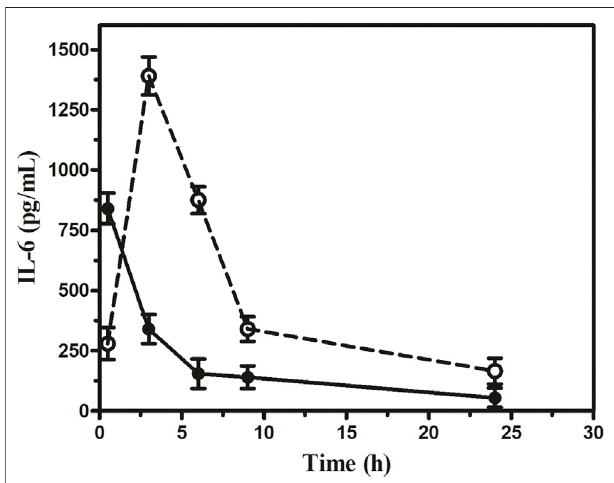
FIGURE 7 | Assessment of interleukin-6 at the different dosages of phage cocktail given 6 h after bacterial challenge. The open circle ( ○ ) denotes (1 × 10 12 PFU/mouse), and the closed circle ( mouse).